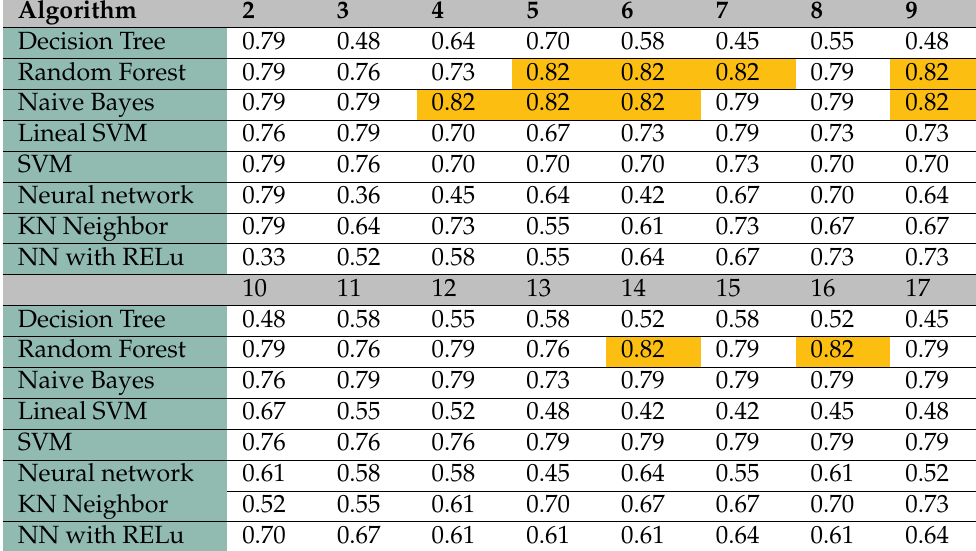
Table 3. Table of accuracy with f_classif without height and